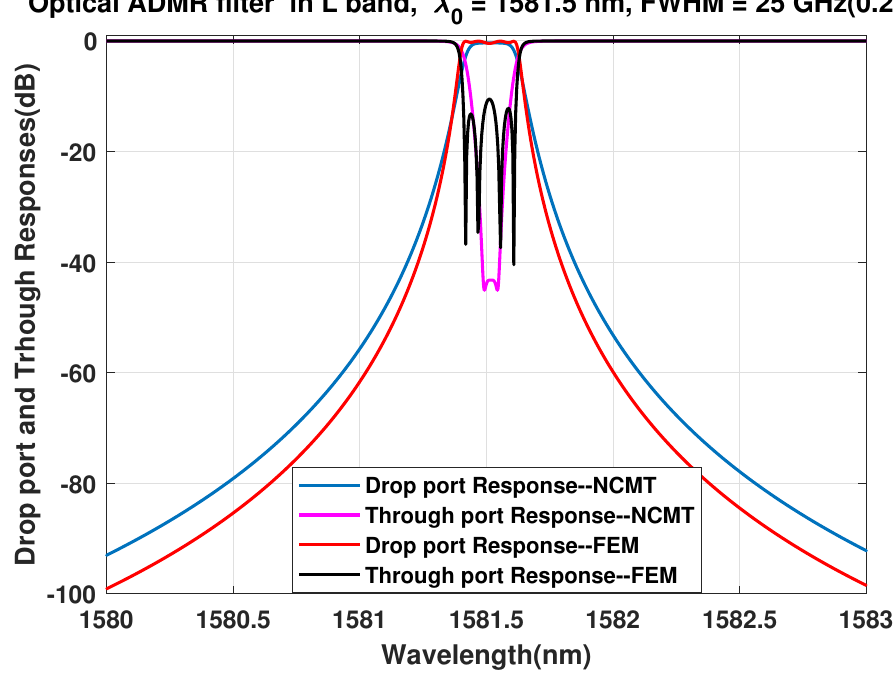
Figure 7. Simulations of the filter responses at through and drop ports using NCMT are plotted together with the S-parameters simulation results given by FEM when the pump is off. T = 298 K in TE mode (TM mode exhibiting a practically similar profile). FWHM = 25 GHz (0.2 nm) centered on the resonance wavelength of 1581.5 nm with FSR = 35 nm, Q = 5933, Finesse = 134 and an extinction ratio (ER) = 139 dB. The generated results demonstrate quite similar results in both methods, though there is a slight detune of the design central wavelength in FEM. This value is detuned from 1581.5 nm to 1581.52 nm due to differences in nonlinear computation accuracy in both methods. In addition, a slight increase in losses from 0.4 dB to 0.91 dB in the bandpass is observed in FEM results, mainly due to the coupling losses in different sections of the